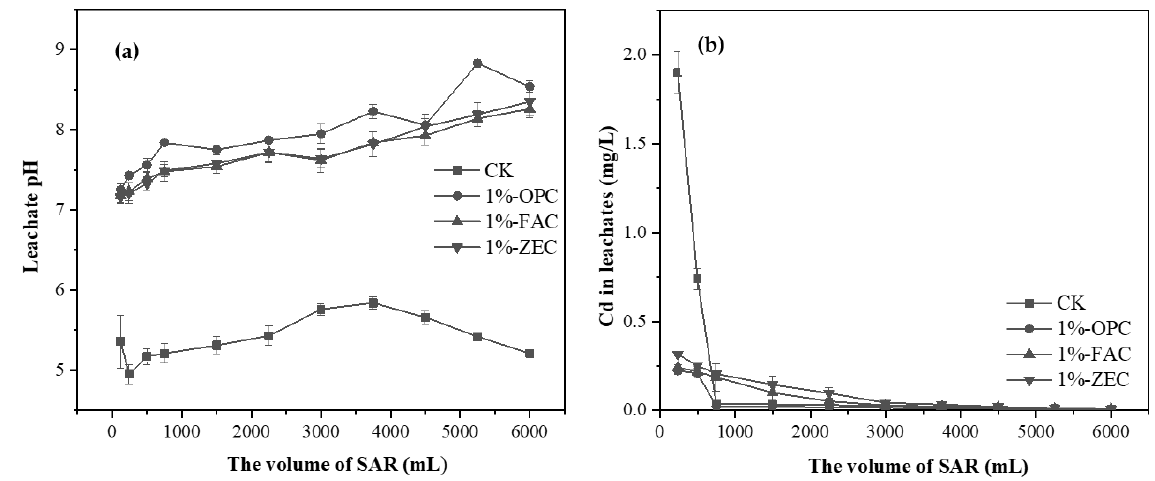
Figure 7. Average leachate pH values and Cd concentrations after leaching with SAR (pH 4.0). Treatments: control (CK), Figure 7. Characterization of leachate. Notes: ( a ) The leachate pH values leached with SAR (pH 4.0); ( b ) The leachate Cd cement paste (OPC), fly ash cement (FAC) paste, and zeolite cement (ZEC) paste. concentrations leached with SAR (pH 4.0). Treatments: control (CK), cement paste (OPC), fly ash cement (FAC) paste, and zeolite cement (ZEC)